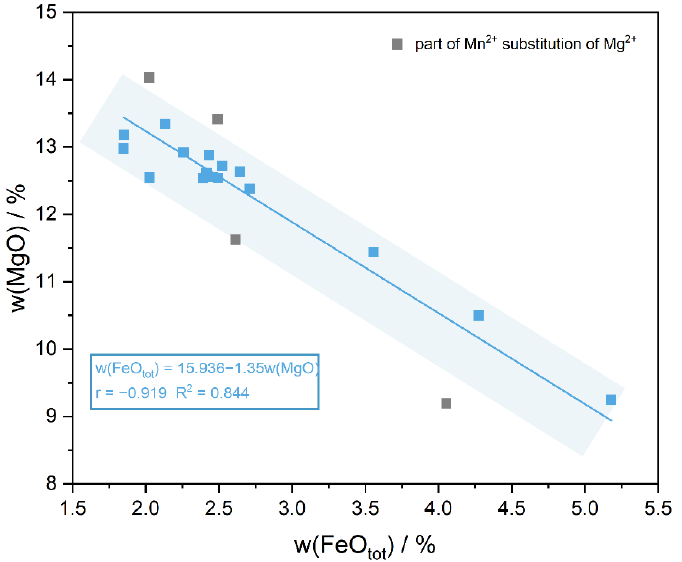
Figure 5. w(FeO tot ) is significantly negatively correlated with w(MgO), and the discrete gray points are due to a small amount of Mg 2+ substitution by Mn 2+ .